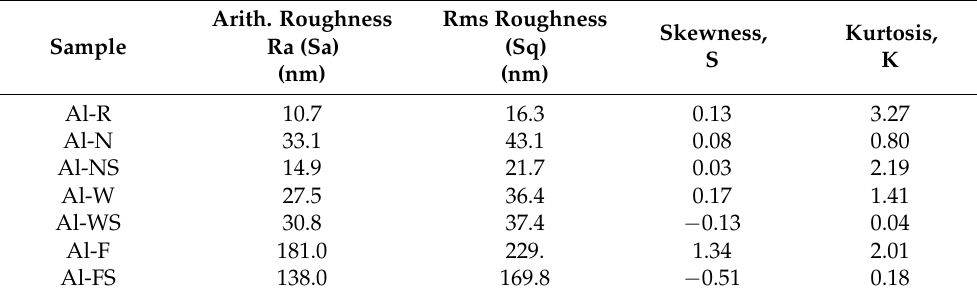
Table 2. Roughness statistic parameters of aluminum alloys at different treatment steps.